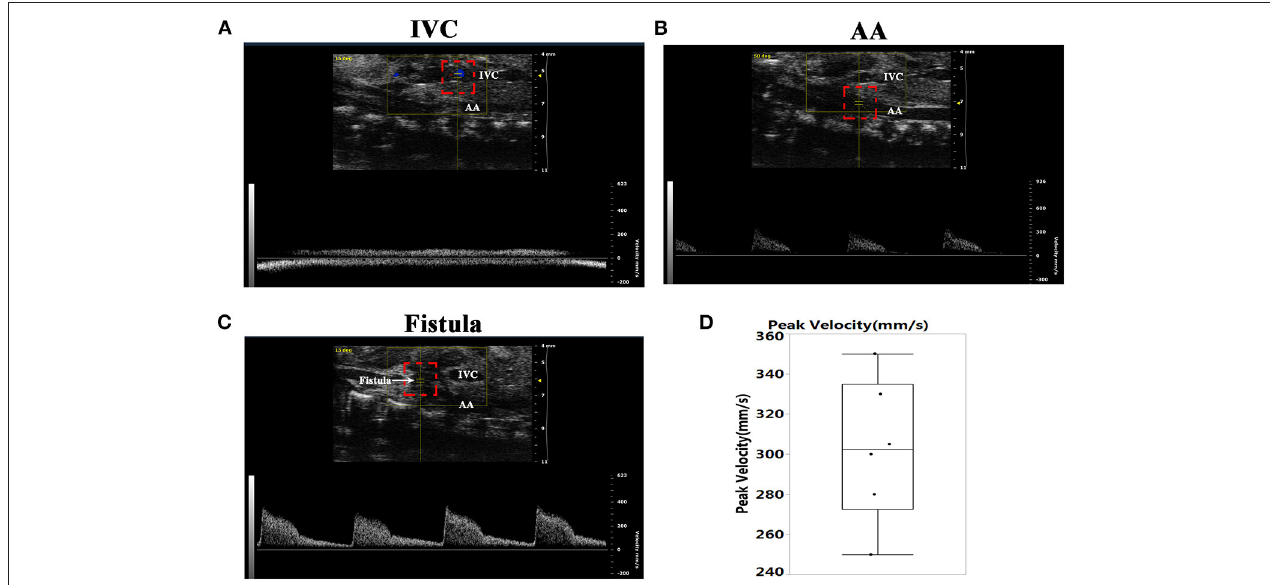
FIGURE 1 | Establishment of the abdominal aorta and inferior vena cava fistula (AVF). (A) The inferior vena cava (IVC) manifested no pulsatile blood flow. (B) There was pulsatile blood flow in the abdominal aorta (AA), with a peak blood flow velocity of 300 mm/s. (C) Representative image of the pulsating blood flow at the fistula, with a peak blood flow velocity of 400 mm/s. (D) Quantification of peak velocity at the